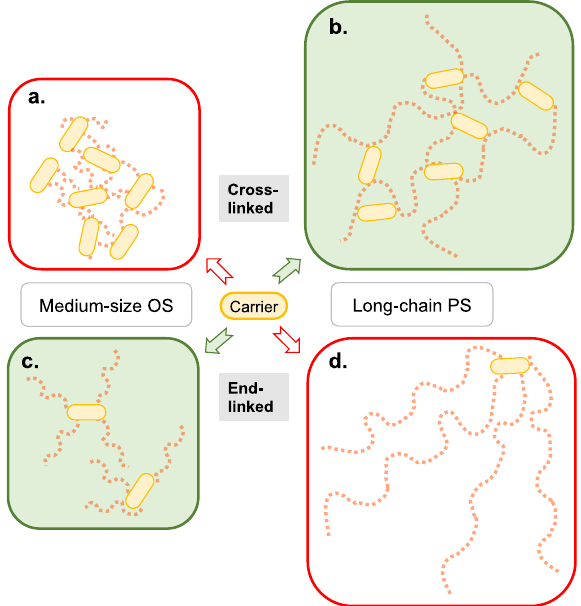
Fig. 2 The four possible glycan activation categories. The basic structures of resultant glycoconjugates are shown. Glycan chains are depicted as strings of red squares, where each square indicates an epitope (see Fig. 1). Random activation of glycans results in cross- linked medium-sized oligosaccharide (OS) glycoconjugates ( a ) or cross-linked long-chain polysaccharide (PS) conjugates ( b ). Activa- tion of glycan termini yields end-linked medium-sized OS glyco- conjugates ( c ) or end-linked long-chain PS conjugates ( d ). Rarely performed activation of both ends of glycan chains may yield vaccines with a low-to-intermediate level of cross-linking. In current practice, b and c result in better-optimized glycoconjugate vaccines (see text for